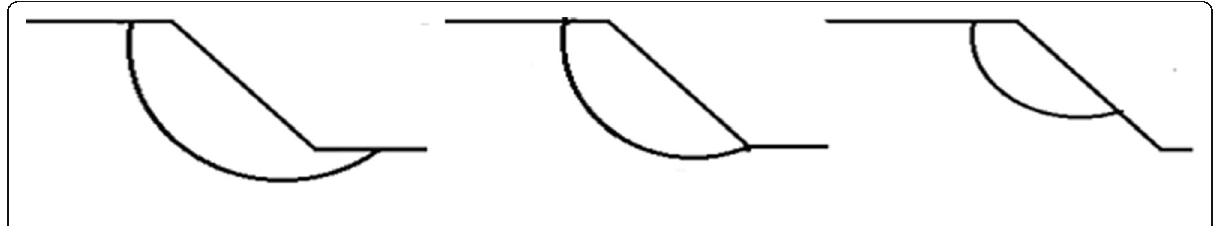
Fig. 1 Types of slope failure a base slide, b toe slide, and c slope